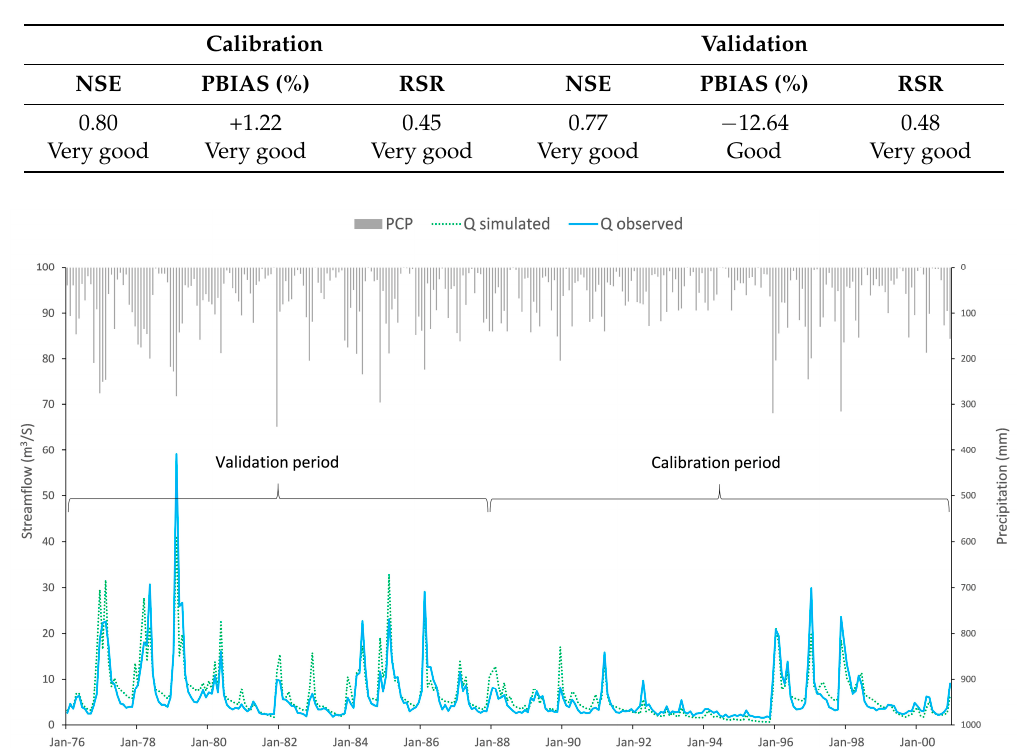
Figure 2. Soil and Water Assessment Tool (SWAT) model calibration and validation. Validation